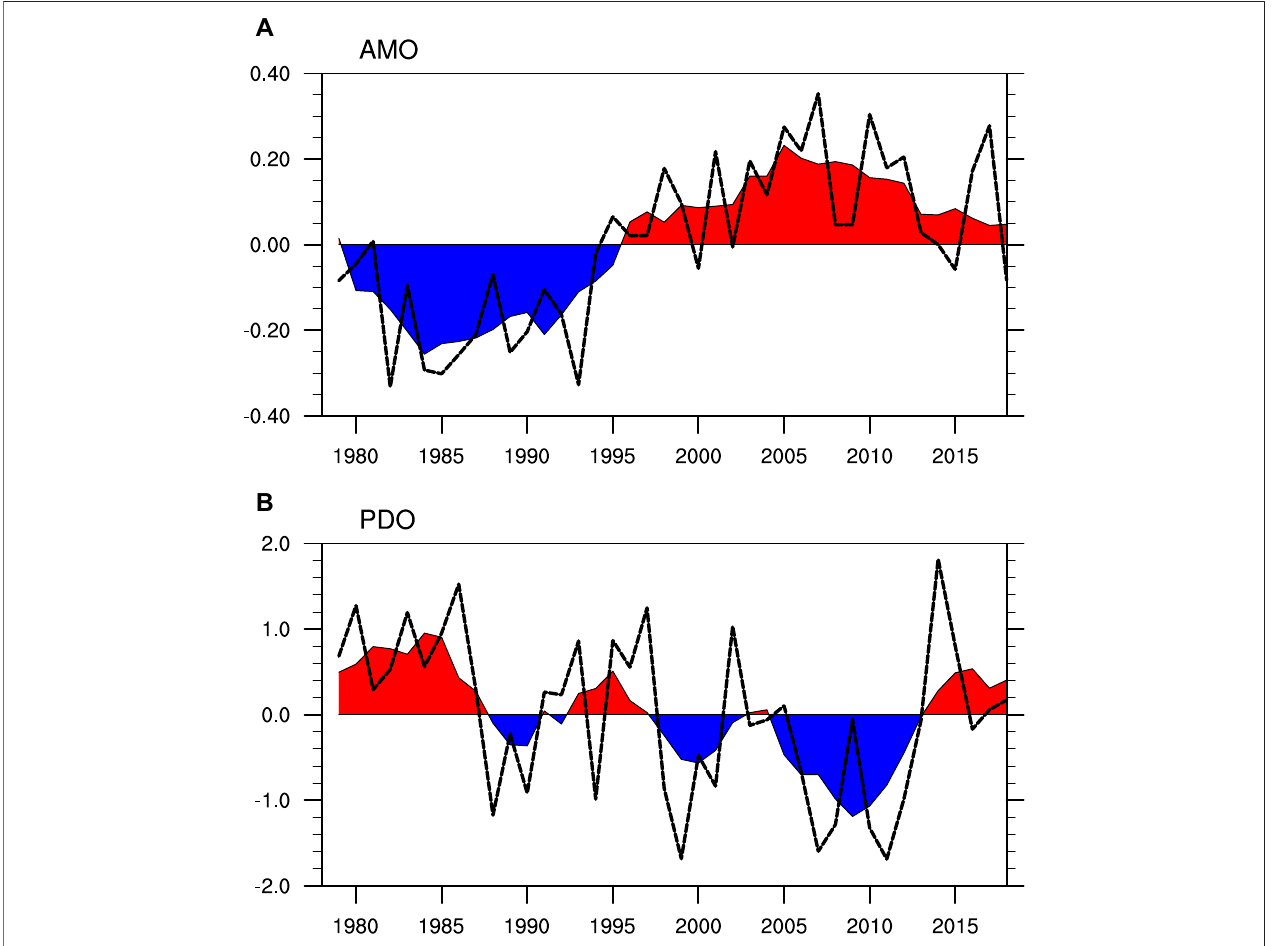
FIGURE 1 | The winter (A) AMO index and (B) PDO index (black dash line) from 1979 to 2018. The fi lling curve is the 5-year running averaged values (red and blue shading).